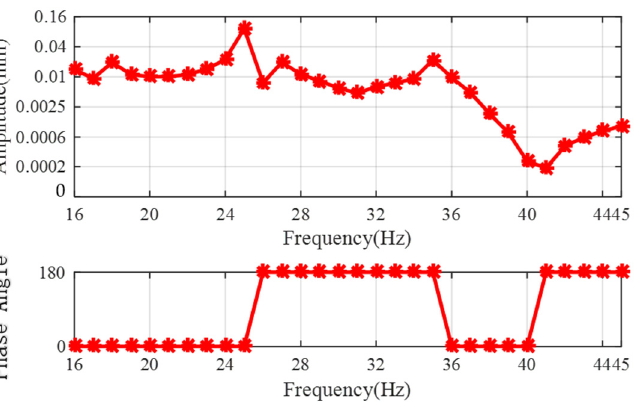
Figure 18. Amplitude response curve of the terminal surface after the optimization of the bar thickness.